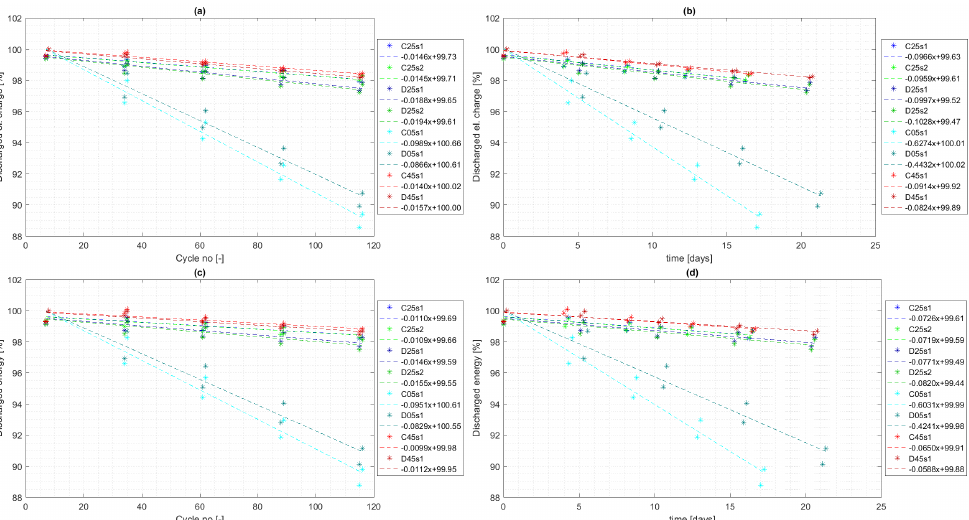
Figure 14. Capacity fade and energy decrease measured and regressed for all cycle aging cells for capacity test cycles depending on cycle no. and time. All the values are normalized to the second cycle of the first two consecutive capacity tests (cycle no. 8), so that this value is equal to